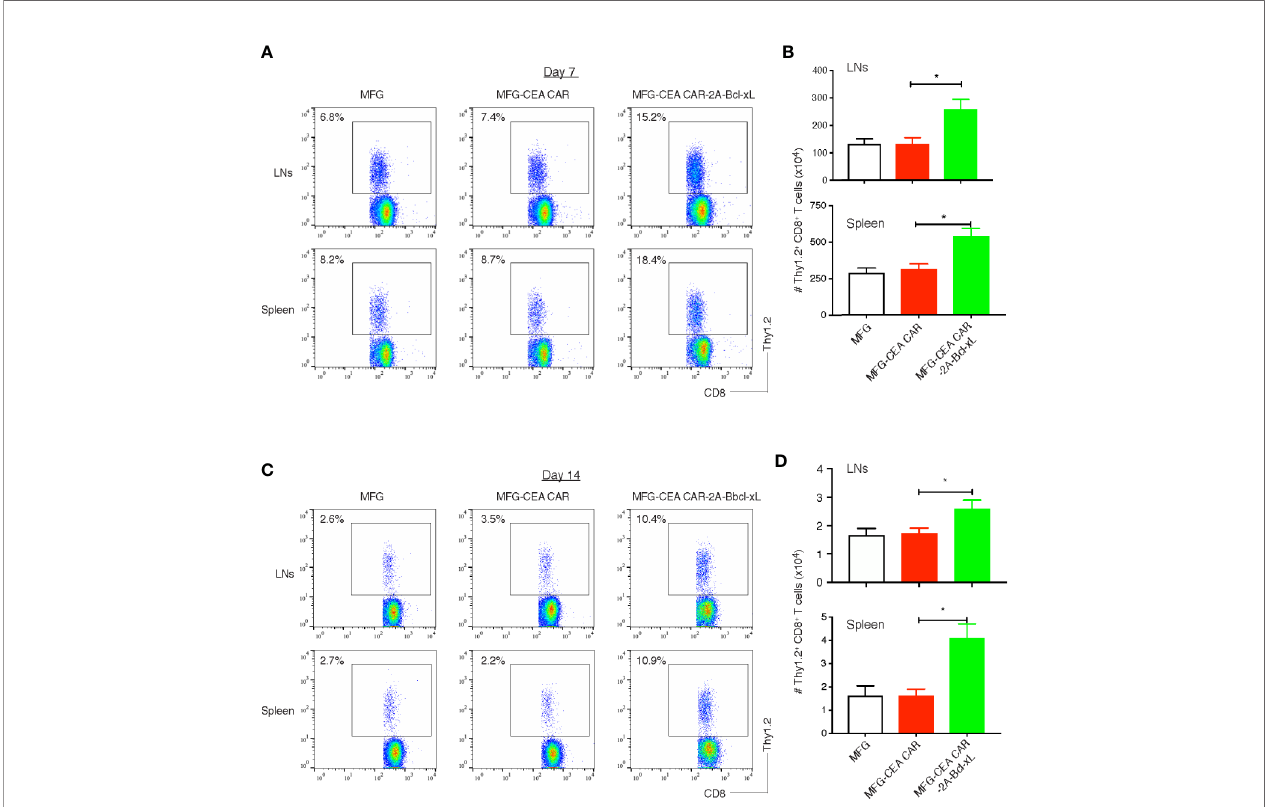
FIGURE 5 | Bcl-xL promoted the persistence of carcinoembryonic antigen (CEA) chimeric antigen receptor T (CAR-T) cells in vivo . 3×10 6 GFP + CD8 + T cells (Thy1.2 + , Figure 2 ) were adoptively transferred into Thy1.1 congenic mice via the tail vein, and on day 7 and day 14, CD8 + Thy1.2 + T cells in the lymph nodes (LNs) and spleen were analyzed by fl ow cytometry. (A) Representatives of the CD8 + Thy1.2 + T cells in the LNs and spleen on day 7. Data are representative of three independent experiments. (B) Cell numbers of CD8 + Thy1.2 + T cells in the lymph nodes (LNs) and spleen on day 7. Data are representative with mean ± S.E.M. percentage change from three independent experiments (* P <0.05, Student ’ s unpaired t -test). (C) Representatives of the CD8 + Thy1.2 + T cells in the LNs and spleen on day 14. Data are representative of three independent experiments. (D) Cell numbers of CD8 + Thy1.2 + T cells in the LNs and spleen on day 14. Data are representative with mean ± S.E.M. percentage change from three independent experiments (* P < 0.05, Student ’ s unpaired t